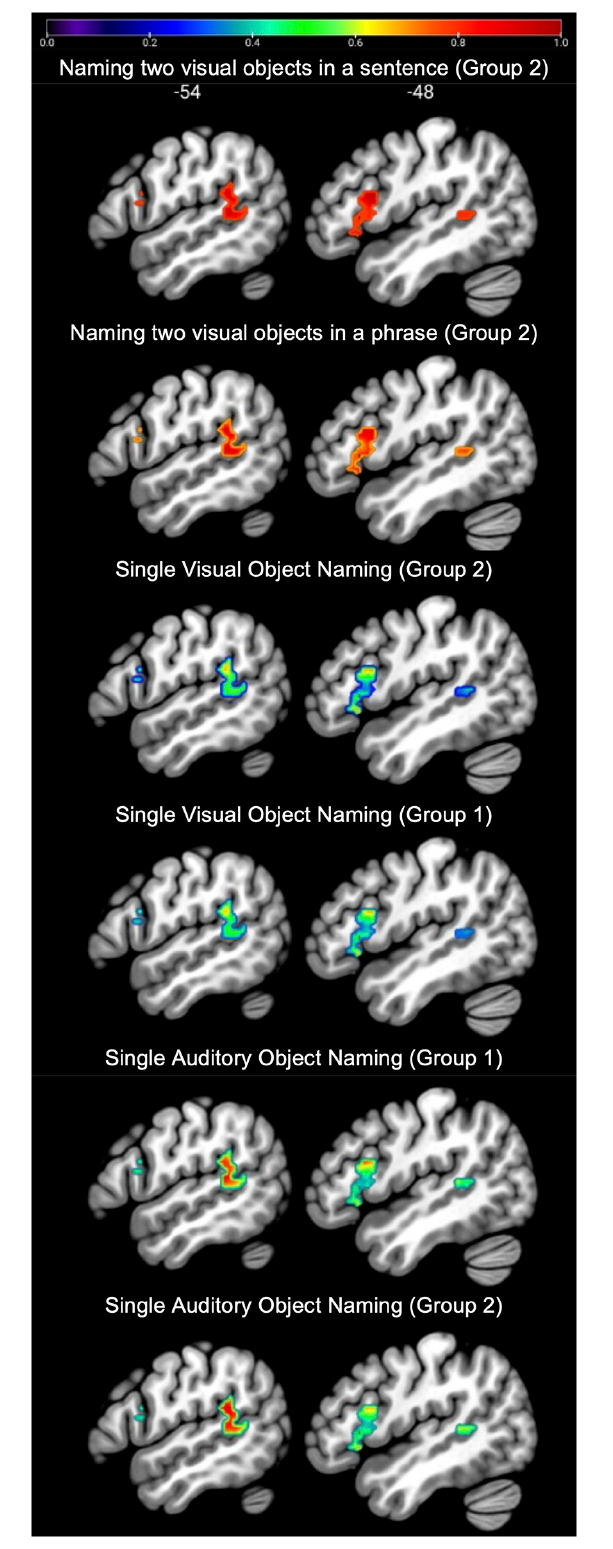
FIGURE 6 | Consistency in activation within language regions of